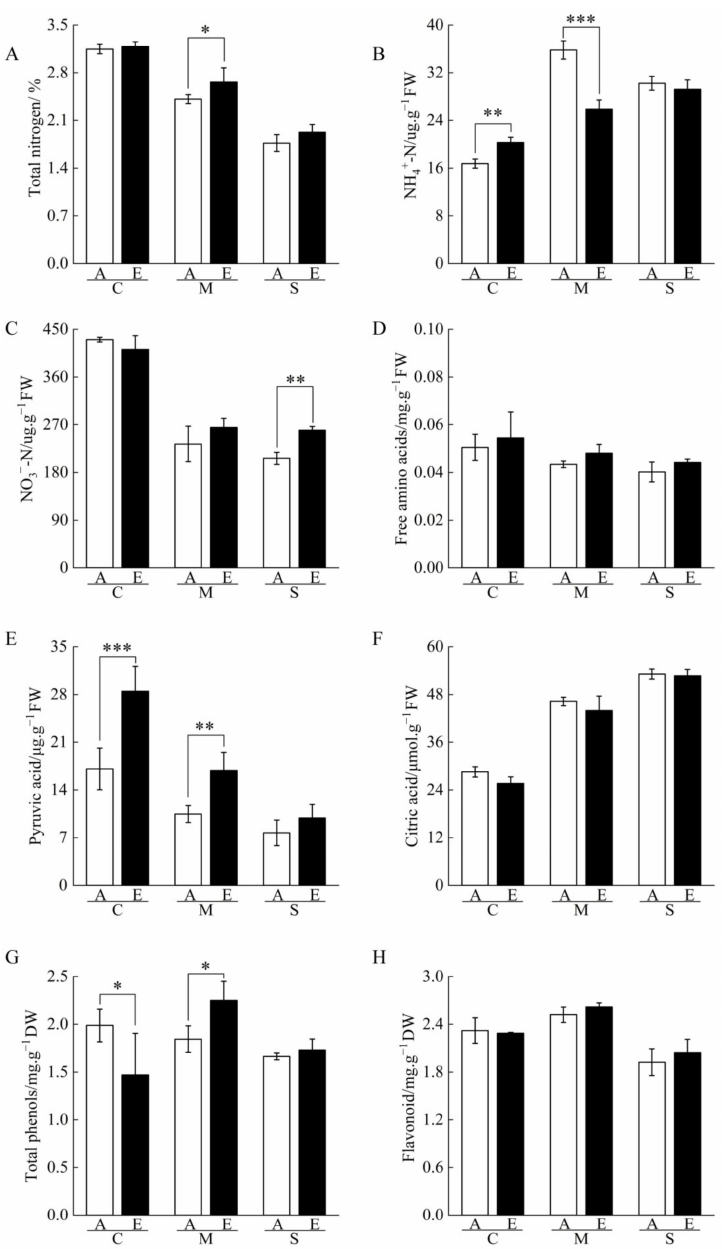
Figure 6. Effects of [CO 2 ] enrichment on the contents of metabolism-related compounds in roots of cucumber seedlings under drought stress. ( A ) Total nitrogen, ( B ) NH 4+ -N, ( C ) NO 3 − -N, ( D ) Free amino acid, ( E ) Pyruvic acid, ( F ) Citric acid, ( G ) Total phenols, ( H ) Flavonoid. All results are expressed as the mean ± standard deviation (SD) of three repeated values; *, difference is significant at the 0.05 level; **, difference is significant at the 0.01 level; ***, difference is significant at the 0.001